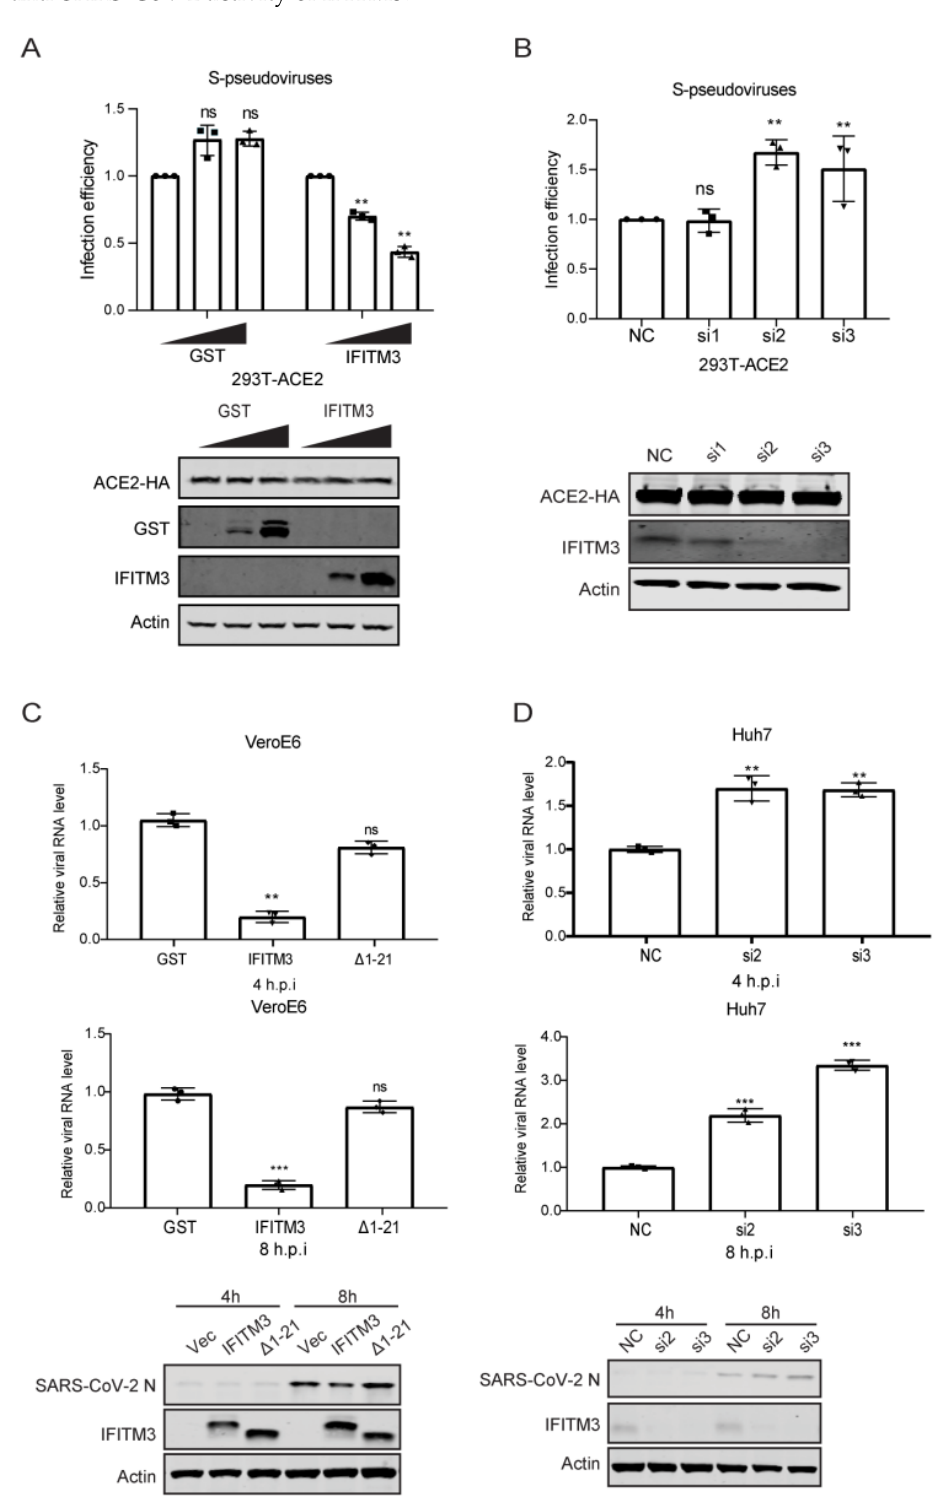
and N protein expression increased by 2-fold (Figure 1D). These data demonstrate the anti-SARS-CoV-2 activity of IFITM3.